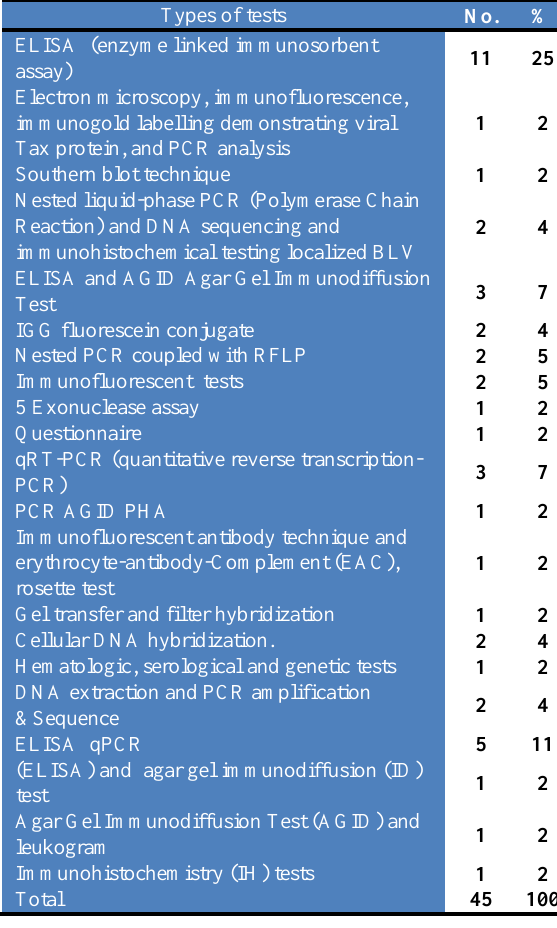
Table, 5: The main types of tests use in